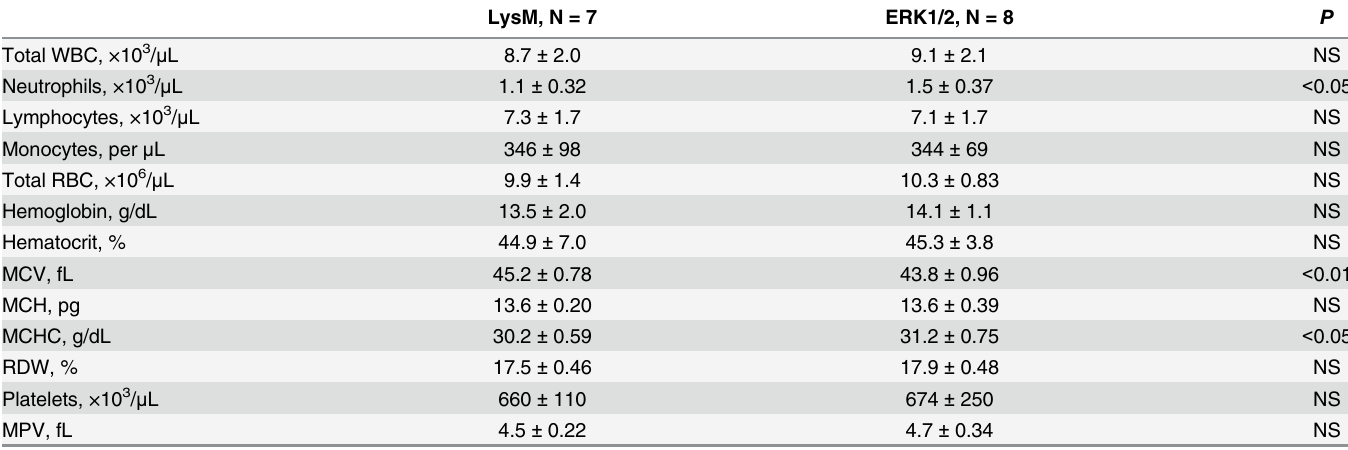
Table 2. Complete blood count data.